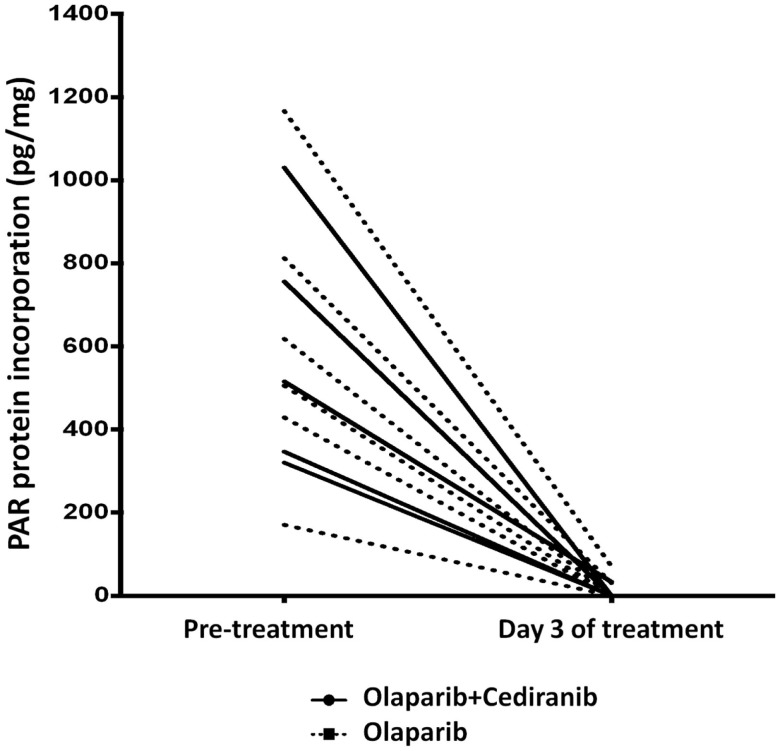
PAR incorporation. Marked reduction in PAR was seen in all patients treated with olaparib-based therapy. Solid line represents patients treated with olaparib/cediranib and dotted line represents patients treated with olaparib alone.